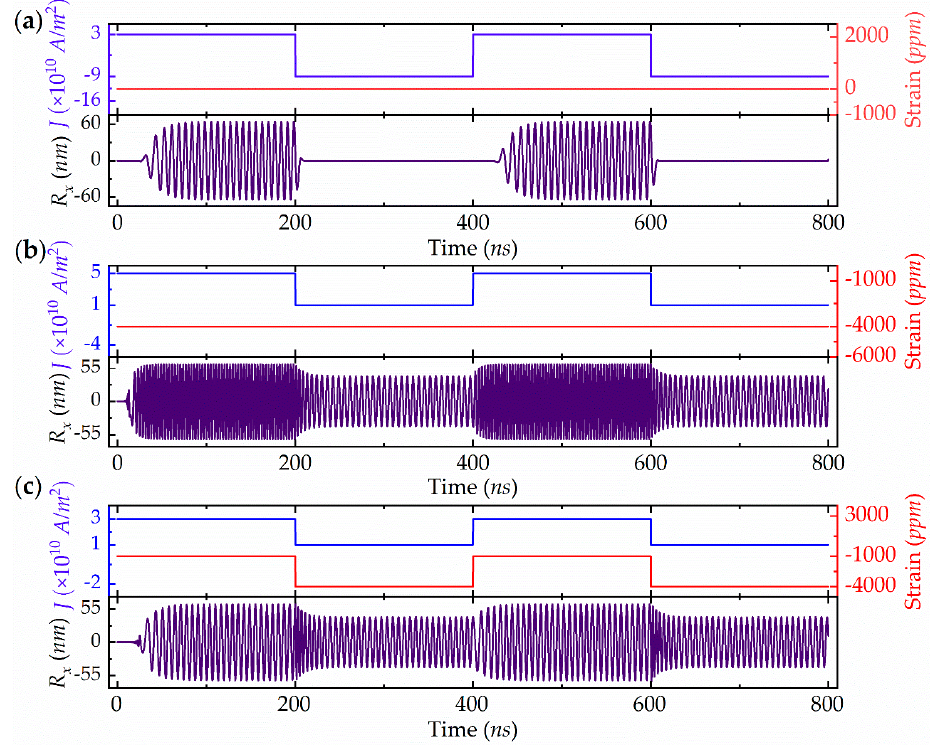
Figure 5. RV-STNO based BASK modulation simulations at ( a ) two-distinct current pulses without piezostrain, ( b ) two distinct current pulses with a fixed piezostrain, and ( c ) two distinct current- piezostrain-combined